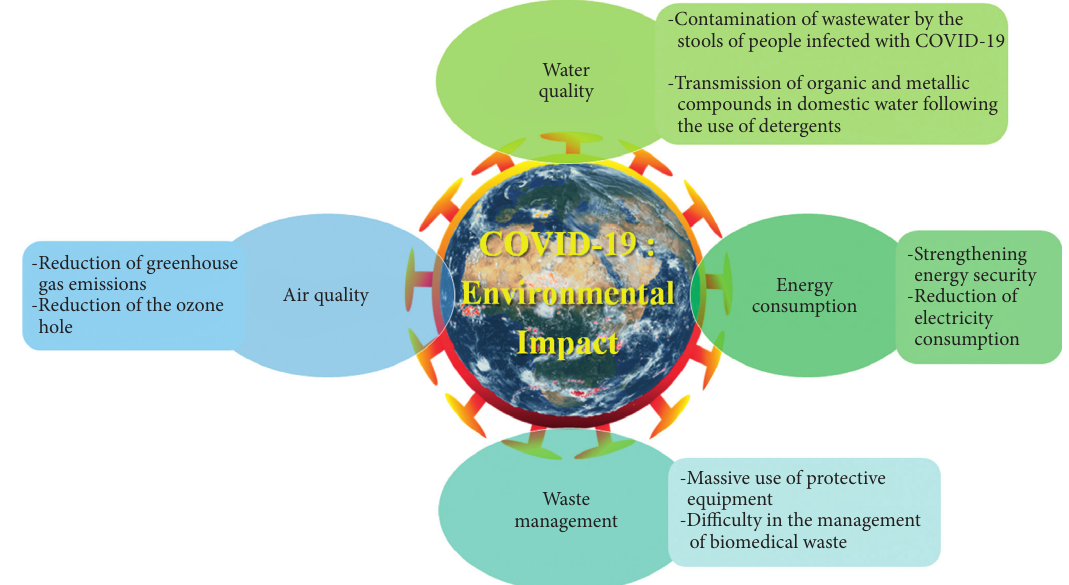
Figure 2: Impact of COVID-19 on the